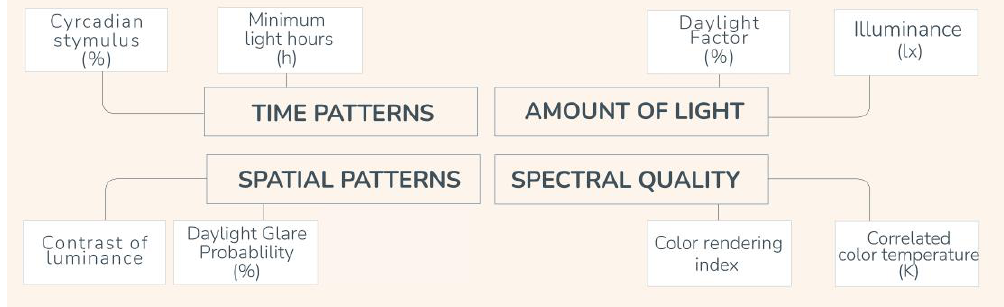
Figure 2. Parameters describing natural light in a given space.